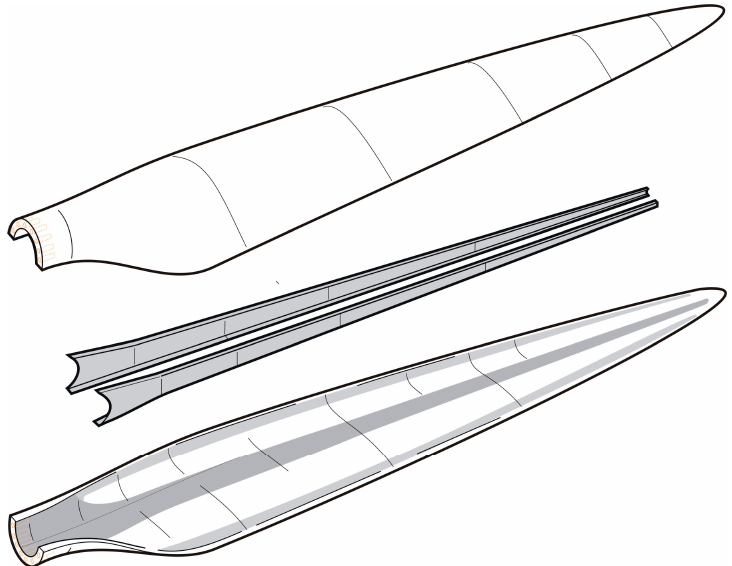
Figure 3. Schematics of the manufacturing of a wind turbine rotor blade by assemblage and bonding of two aeroshells and two shear webs (gray color indicates the primary load-carrying composites).